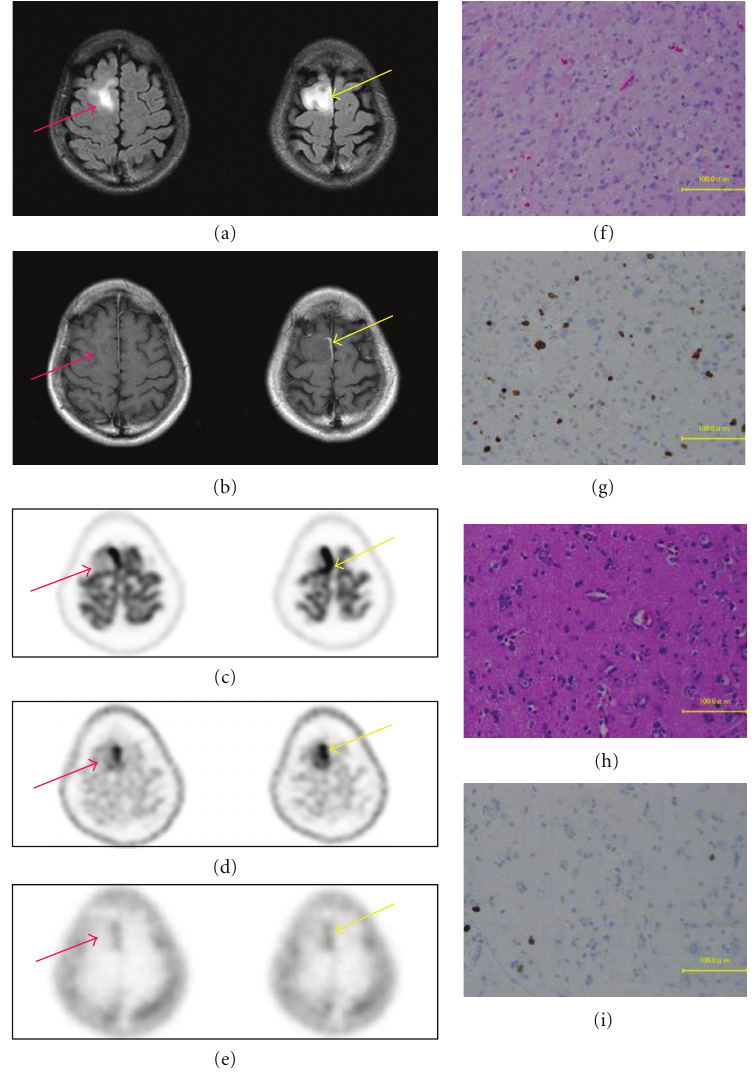
Figure 4: A 31-year-old woman with high intensity in the right frontal lobe in FLAIR MRI (a) and slightly enhanced lesion in Gd-enhanced MRI (b). FDG-PET demonstrated increased FDG uptake within the tumor (c). MET-PET demonstrated increased MET uptake within the tumor (d). FLT-PET demonstrated increased FLT uptake within the tumor (e). Areas of di ff erent enhancement and uptake between FDG, MET, and FLT are projected on the tumor, in order to perform histological sampling for further correlation during the resection (yellow arrow, red arrow). Yellow arrow demonstrates anaplastic astrocytoma (f) within T / N ratio of FDG-PET (2.85), MET-PET (4.57), and FLT- PET (9.65). Ki-67 index from the specimen indicated by yellow arrow was 20% (g). Red arrow demonstrates di ff use astrocytoma area (h) within T / N ratio of FDG-PET (0.76), MET-PET (2.08), and FLT-PET (4.65). Ki-67 index from the specimen indicated by red arrow was